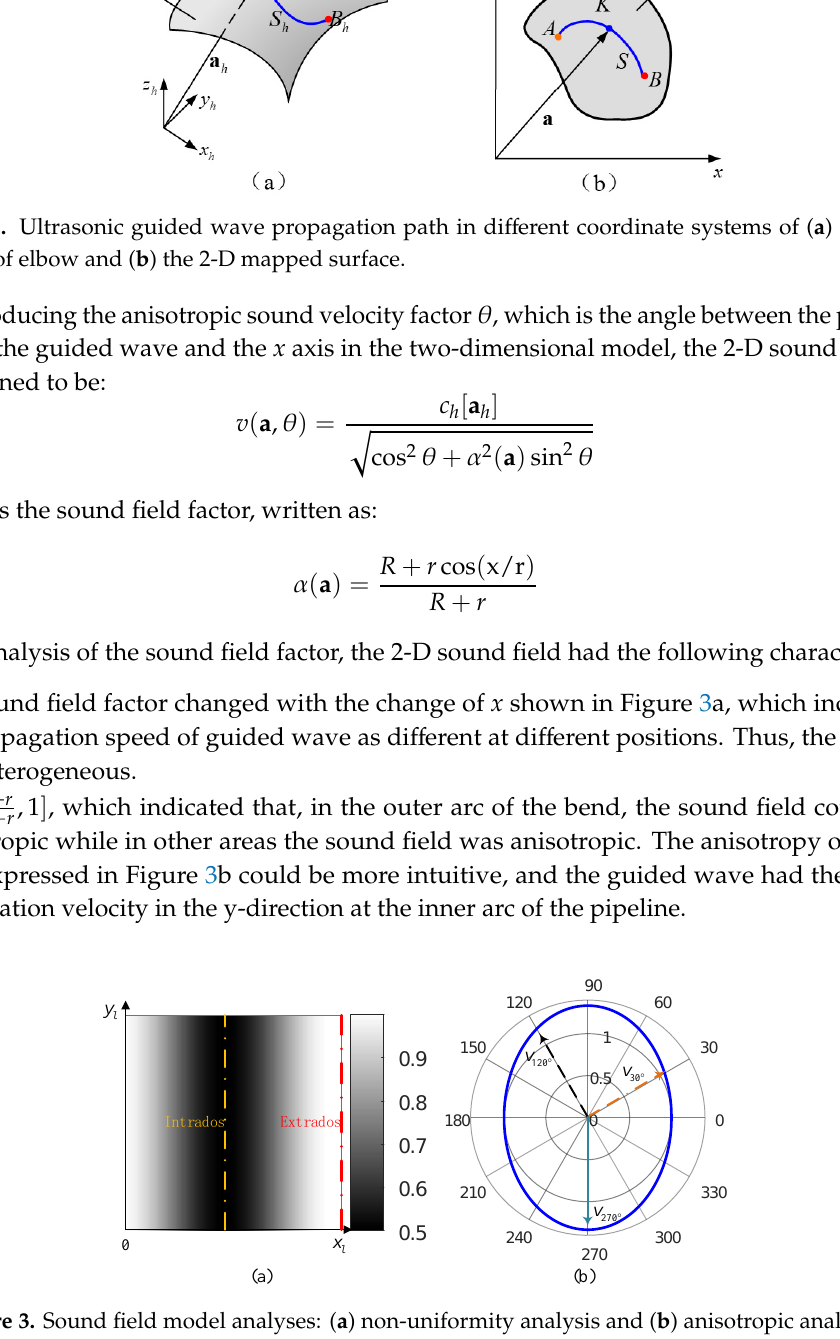
Figure 3. Sound field model analyses: ( a ) non-uniformity analysis and ( b ) anisotropic analysis.